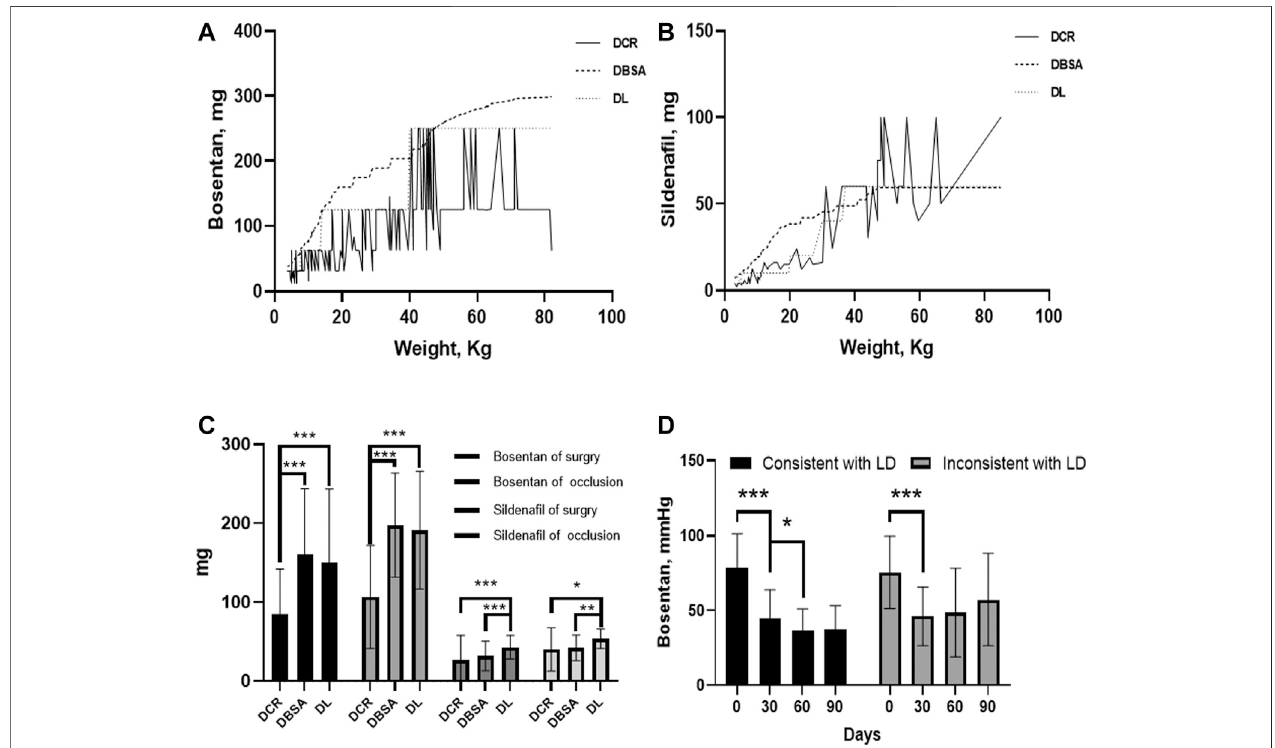
FIGURE5| Thecomparisionofthetherapeuticandprognosticeffectsofdrugfactors. Threedoseswereincludingdosebasedonbodysurfacearea(DBSA),dose based on literature (DL), and based on case review (DCR). (A) Curves of 3 doses of bosentan with body weight. (B) Curves of 3 doses of sildena fi l with body weight. (C) Dosecomparisonof3dosesofbosentanandsildena fi ladministeredindifferentoperations. (D) Thevariationofpulmonaryarterypressureconcerningtheconsistencyor inconsistency of bosentan literature dosage. * p < 0.05; ** p < 0.01; *** p < 0.001.